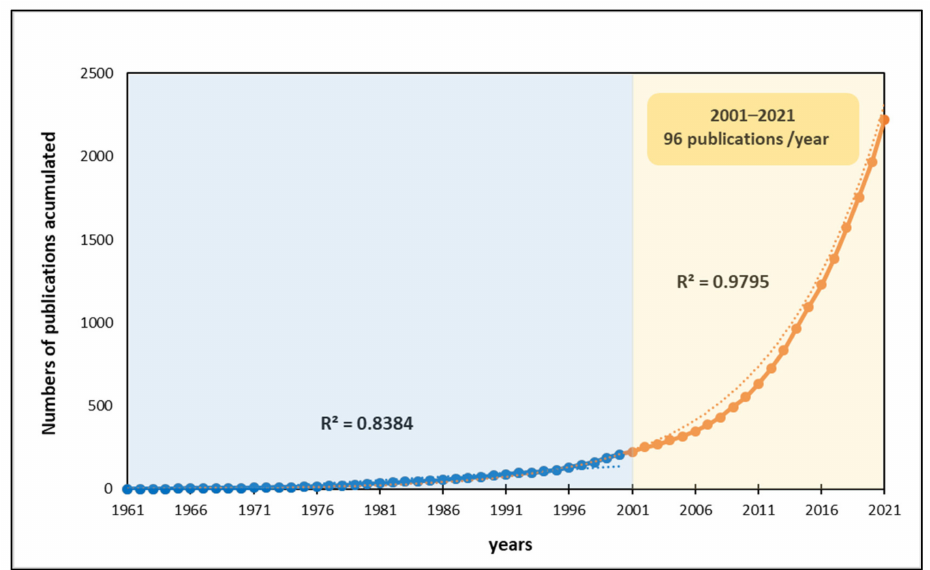
Figure 1. Evolution of the number of publications per year and accumulated in the period 1961–2021, resulting from the search in Scopus of the terms “grazing” and “service”. The adjusted coefficient of determination used in each stage is